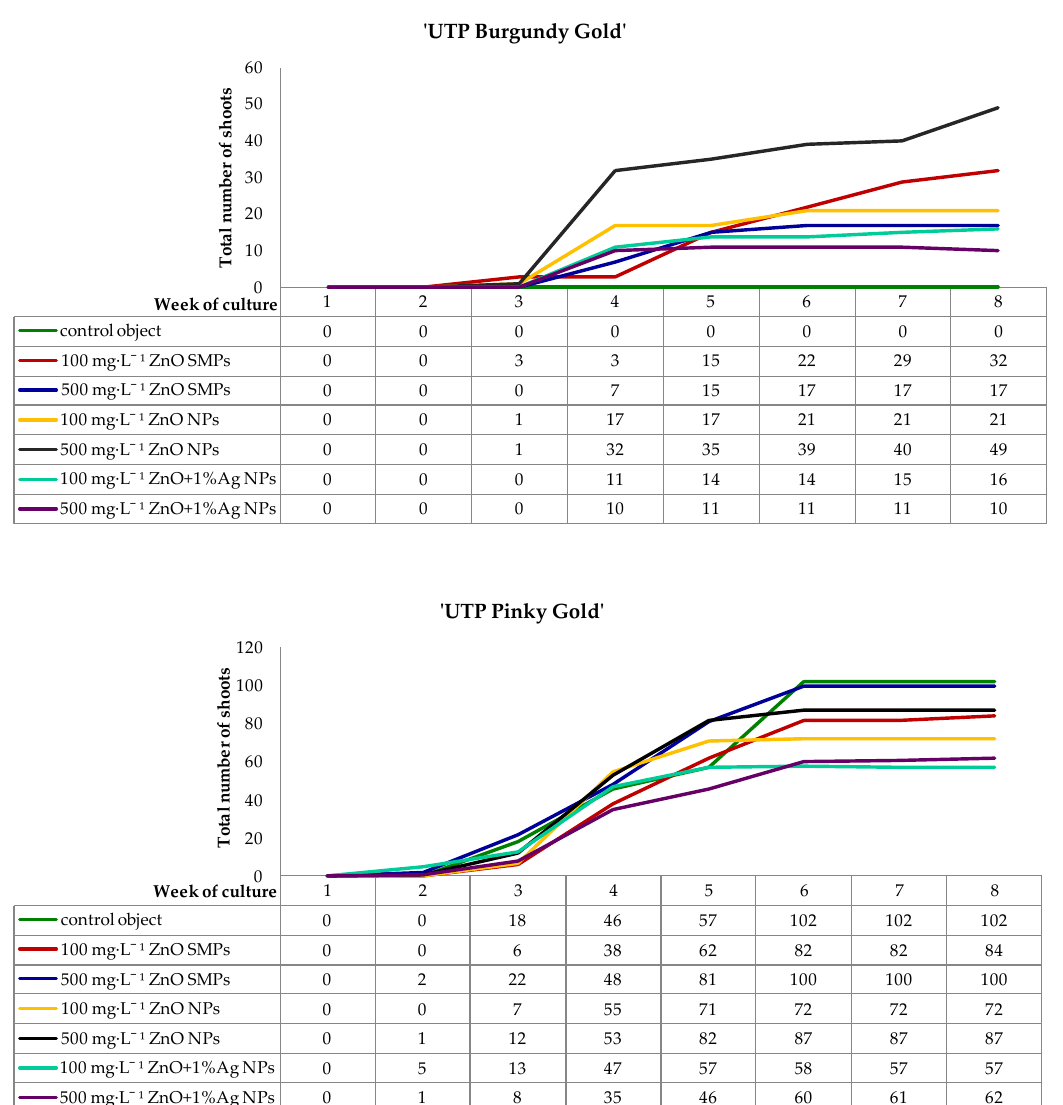
3.5. Adventitious Shoots Regeneration and Biochemical Assay of Phytochemicals During the first week of culture, all inoculated internodes enlarged visually their volume as a result of absorbing water and medium components. The regeneration of green callus, first in the area of cutting edge and next on the whole surface of inoculated internodes, began in the second week of culture. Chrysanthemum ‘UTP Pinky Gold’ proliferated callus more intensively than the ‘UTP Burgundy Gold’ cultivar. Therefore, the formation of adventitious shoots occurred indirectly via calli (Figures 5 and 6).